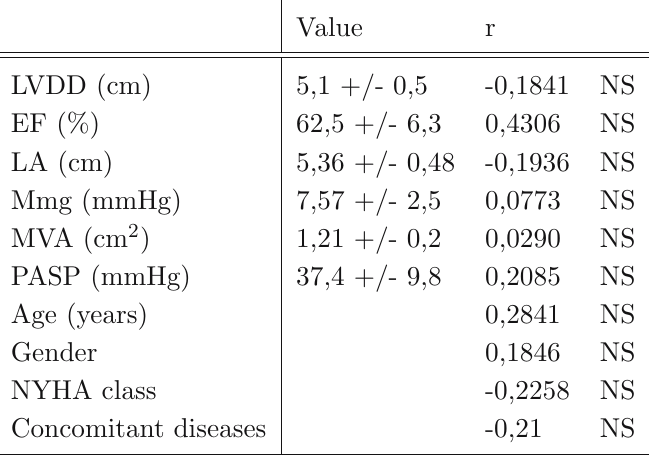
Table 4 Statistical correlation between SR restoration and preoperative echocardiografic